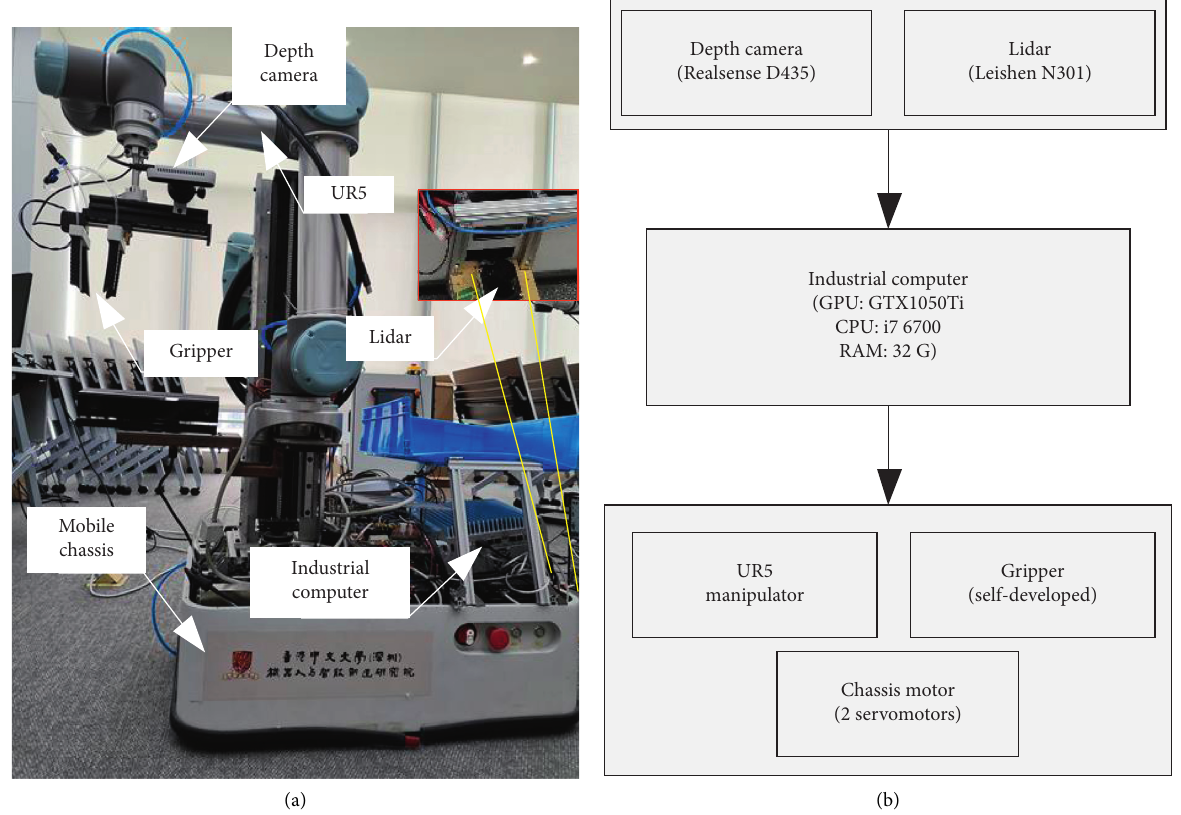
Figure 1: Mobile grasping robot. (a) Photo of the mobile grasping robot. (b) Sensor fusion-based mobile grasping